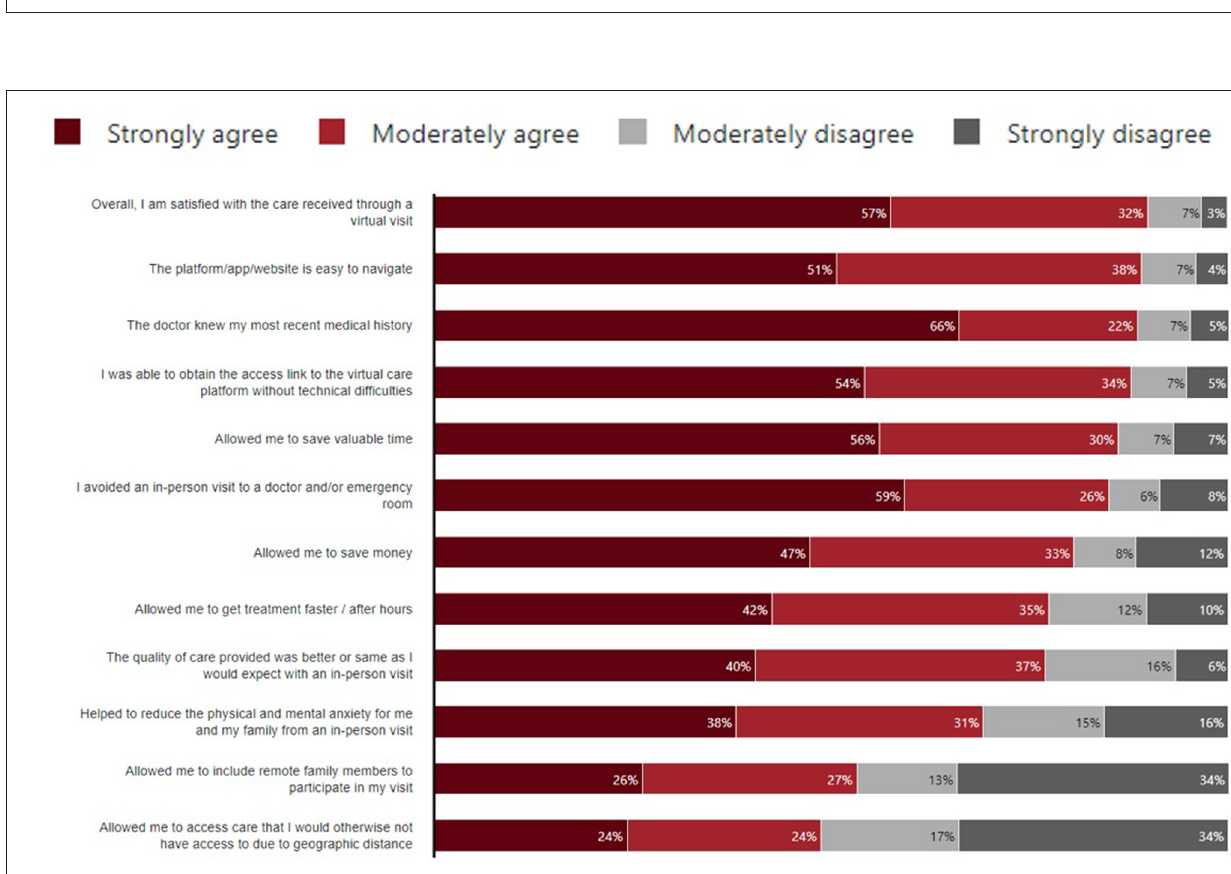
FIGURE 8 | Canadians’ experience with their most recent virtual visit, had they experienced one, 2020. Sourced from a routine representative survey of the Canadian population conducted in 2020, with sample sizes of 6,000 individuals (21).